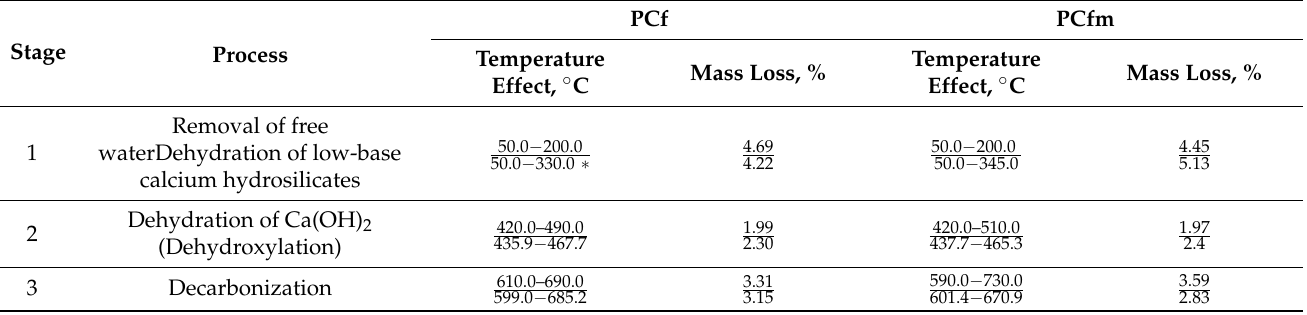
Table 3. Thermal effects and mass losses during heating of PCf and PCfm